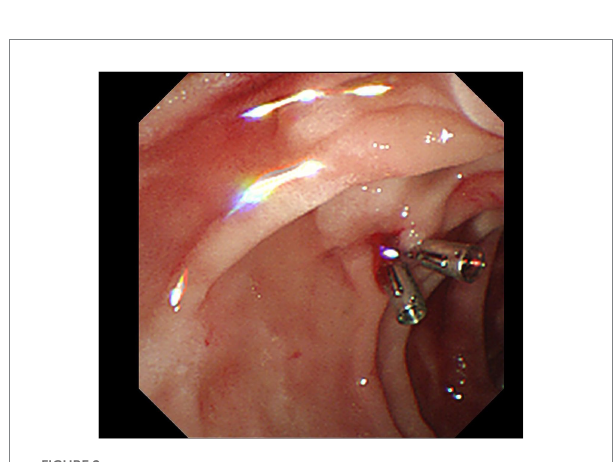
FIGURE 2 Two titanium clips were placed and the bleeding